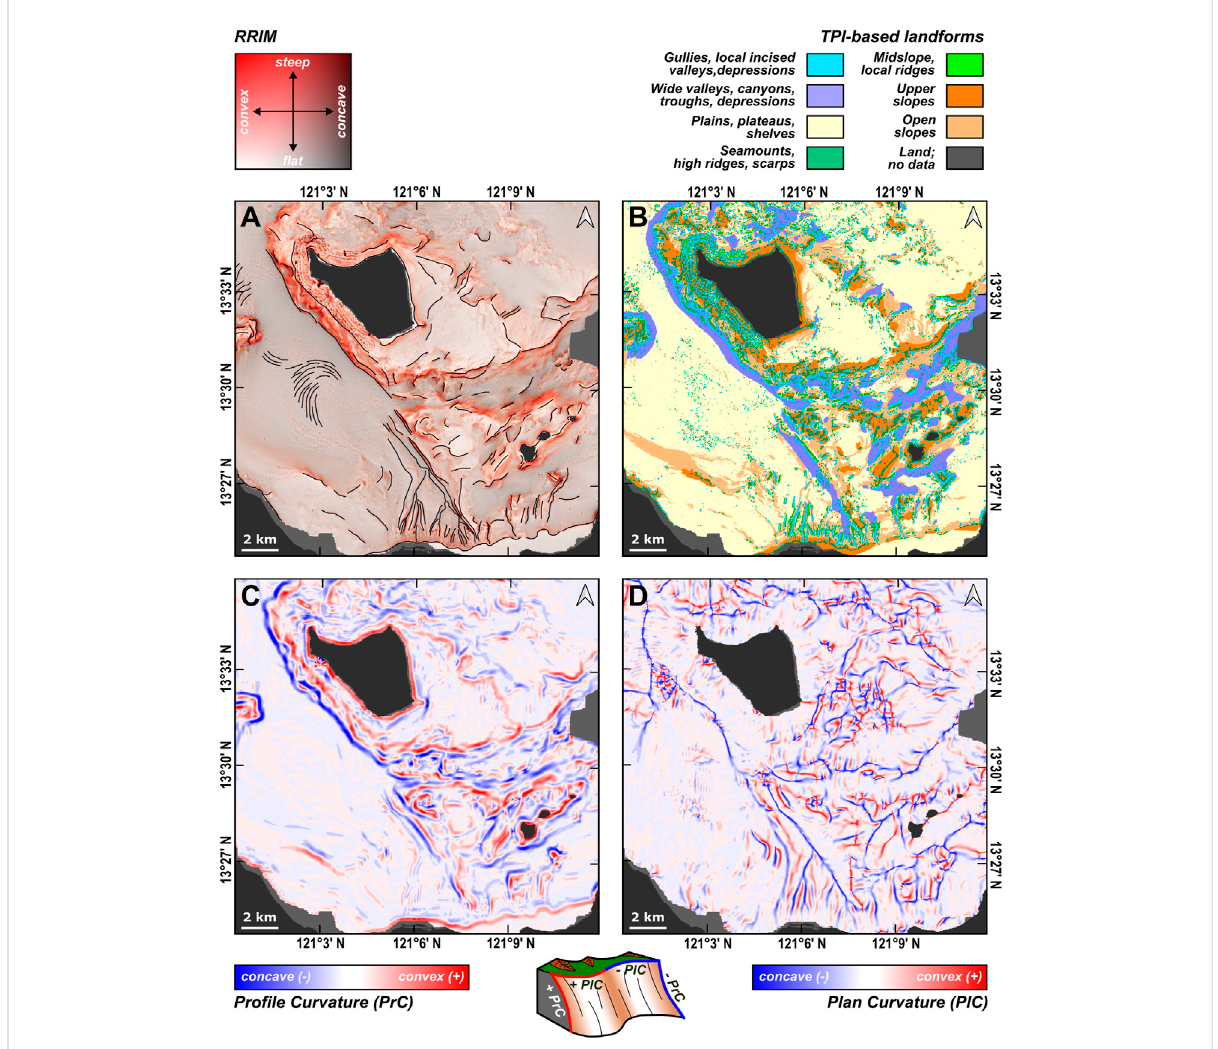
FIGURE 3 DEM-derivedlayersusedinthesubmarinegeomorphologicalmappingoftheSouthPass,VerdeIslandPassage. (A) RedReliefImageMap(RRIM) with manually delineated linear features. (B) Landform classi fi cation based on Topographic Position Index. (C) Pro fi le curvature. (D) Plan